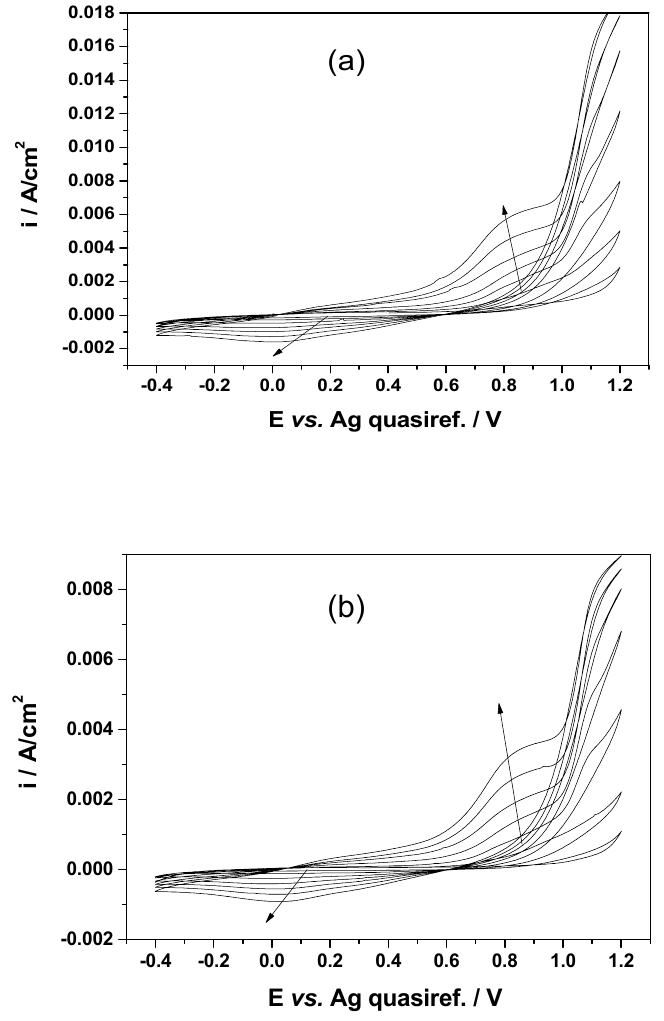
Figure 4. Cyclic voltammograms on IB ( a ) and ND ( b ) NiCr alloys during electrosynthesis of PPy-Indo from ILM-ACN electrolyte containing 0.5 M Py and 0.0175 M Indo. (scan rate of 10 mV s − 1 and 25 °C).